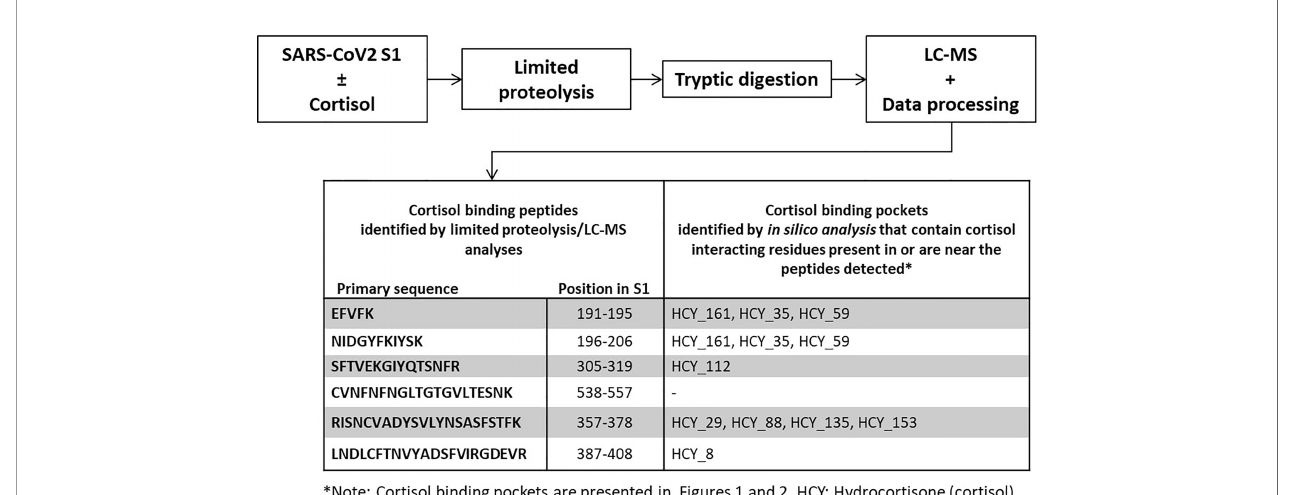
FIGURE 3 | Cortisol binding sites on SARS-CoV-2 S1 identi fi ed by limited proteolysis-coupled mass spectrometry. The unique peptides which were detected by mass spectrometry following limited proteolysis of SARS-CoV-2 S1 incubated with vehicle or cortisol represent cortisol binding sites. Full list of detected peptides is shown in Supplementary Table 1 . Comparison between these cortisol binding sites with the binding pockets we identi fi ed through molecular dynamics and binding energy studies reveal multiple common binding sites identi fi ed by both